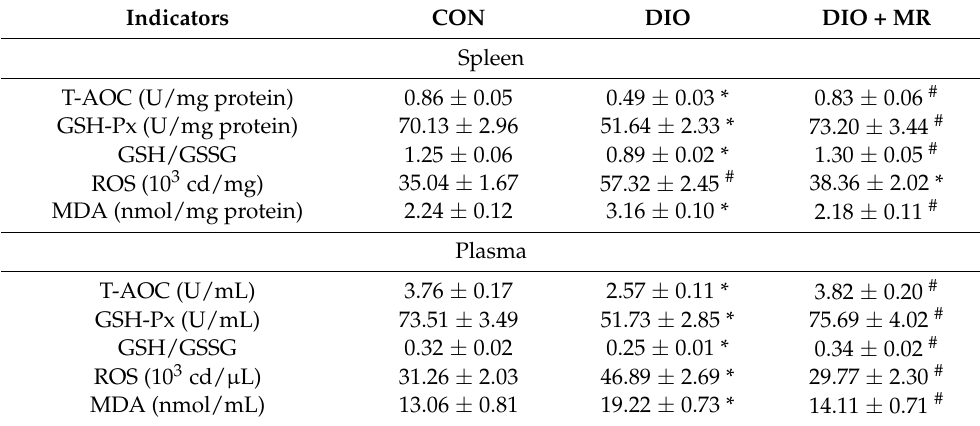
Table 1. Effects of MR on the levels of oxidative stress-related parameters in spleen and plasma in obese mice.